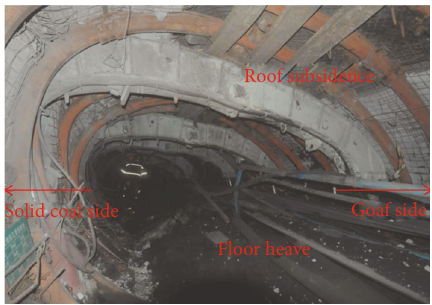
Figure 8: Main roadway destruction